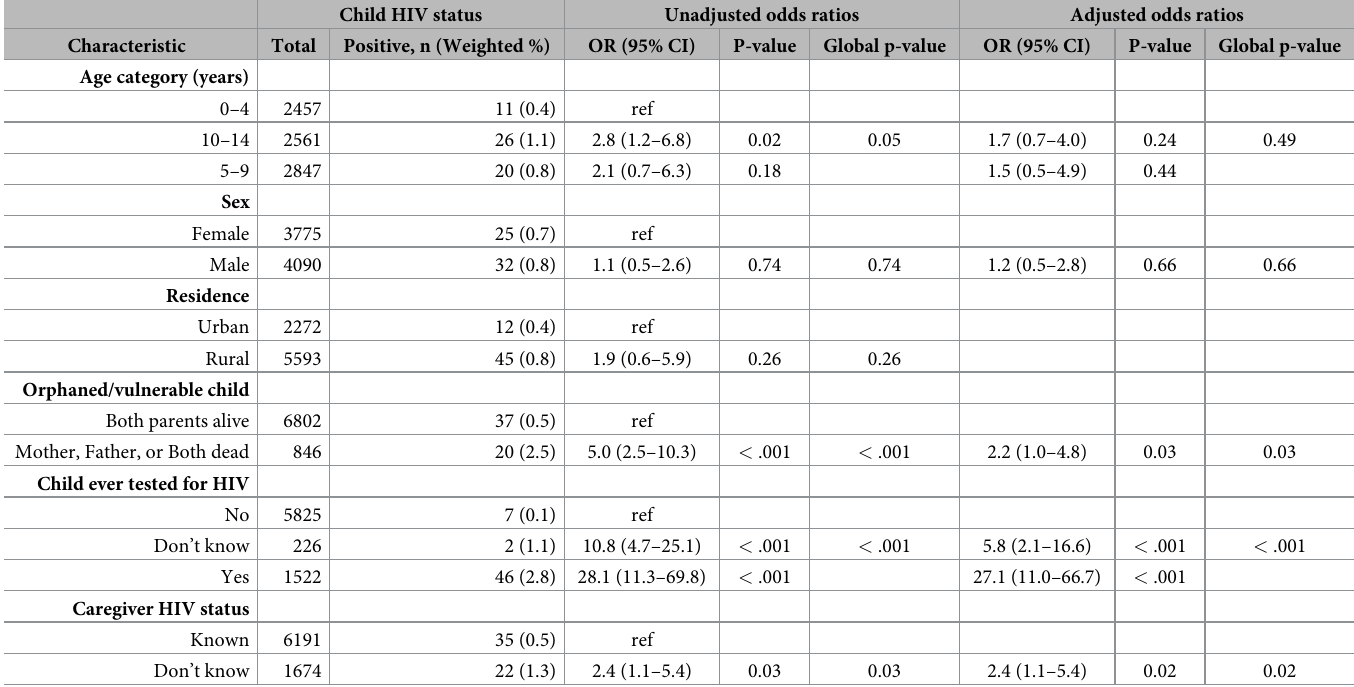
Table 3. Factors associated with HIV prevalence among children aged 0–14 years, KENPHIA 2018.